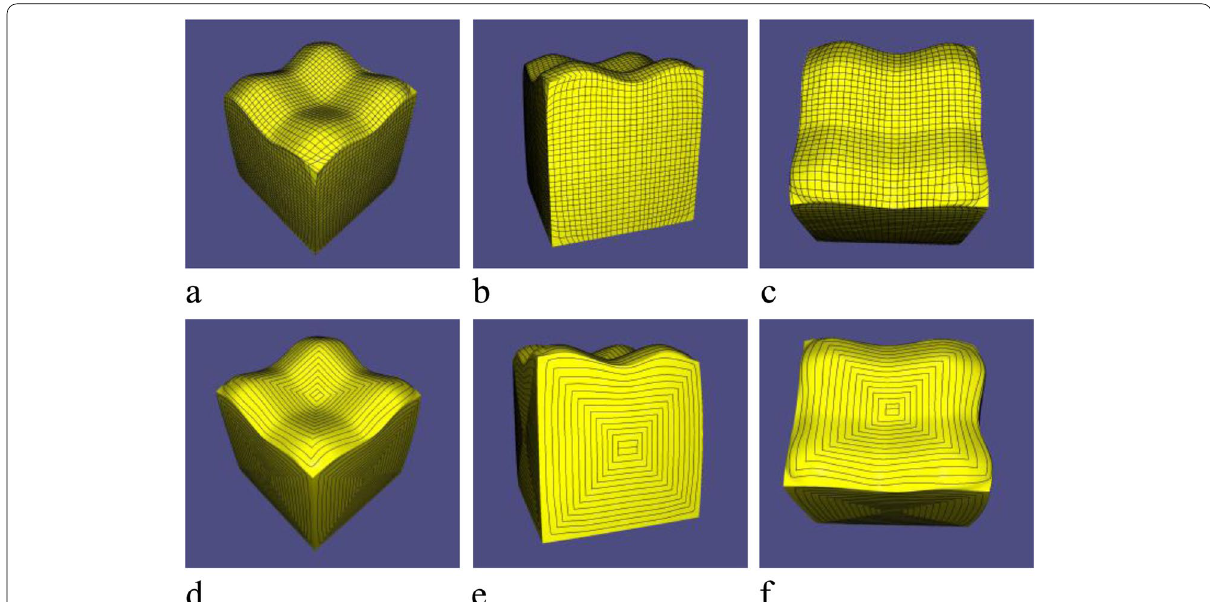
Fig. 21 Tool path of Surfcube model: a ‑ c are model’s grid; d ‑ f are corresponding tool